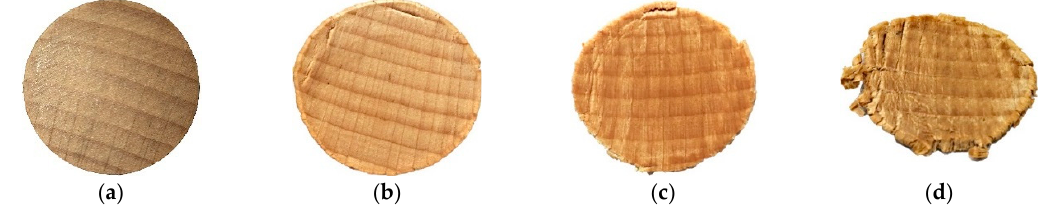
Figure 12. Final failure shapes of DTLD under different strain rates of ( a ) 800 s − 1 , ( b ) 1200 s − 1 , ( c ) 1800 s − 1 , and ( d ) 2000 s − 1 .